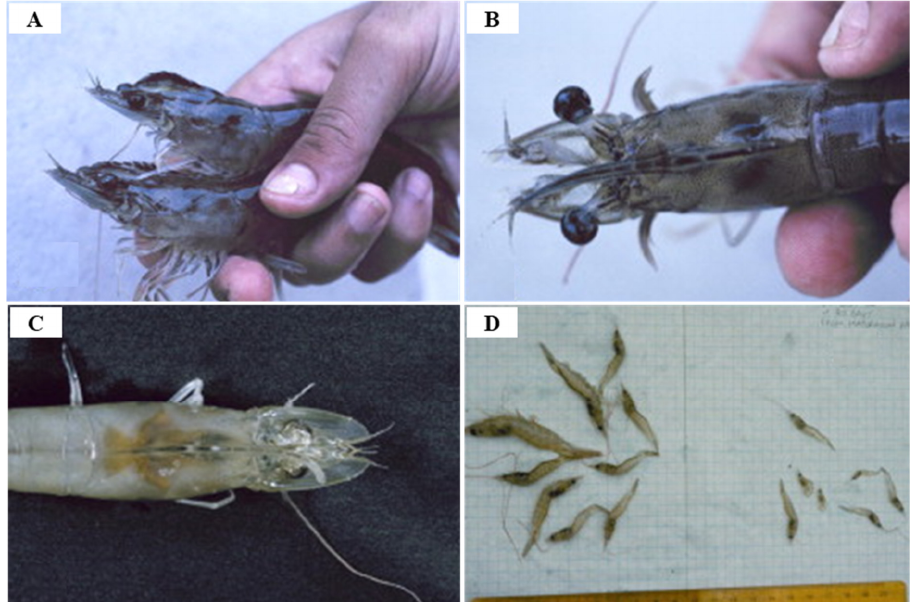
Figure 9. External symptoms of infectious hypodermal and hematopoietic necrosis virus (IHHNV) on shrimp. ( A , B ) subadult Penaeus vannamei with bent (to the left) rostrums, a classic sign of ‘runt deformity syndrome’ (RDS); ( C ) a juvenile P. vannamei with RDS. In this specimen the rostrum is bent to the right and the antennal flagella are wrinkled, brittle and mostly broken-off; ( D ) juvenile P. vannamei with RDS from a nursery population at approximately 60 days post stocking (Reprinted from Journal of Invertebrate Pathology, Vol. 106 (1), Lightner D.V., Virus diseases of farmed shrimp in the Western Hemisphere (the Americas) A rieview, p. 21, Copyright (2011), with permission from